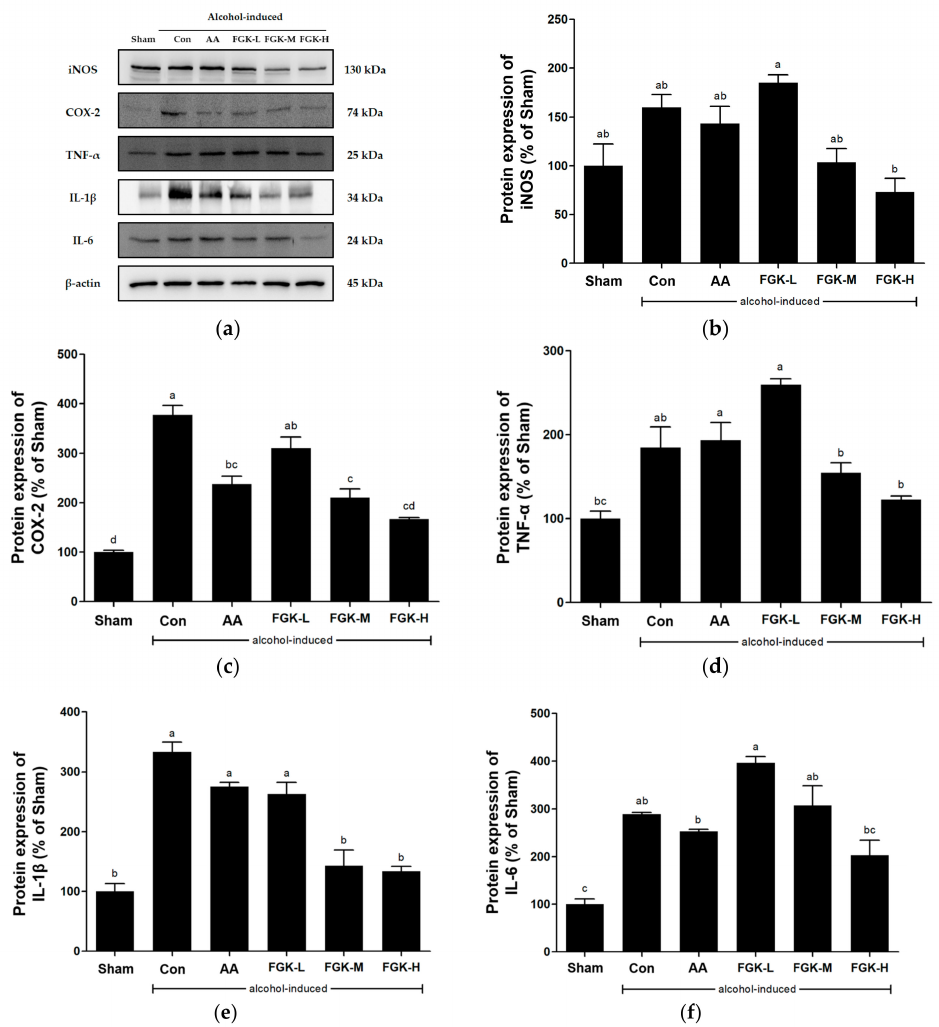
Figure 7. Effects of fermented gold kiwi (FGK) on liver inflammatory mediator levels in alcohol- induced mice. ( a ) Protein expression; ( b ) iNOS; ( c ) COX-2; ( d ) TNF- α ; ( e ) IL-1 β ; and ( f ) IL-6. Sham, mice treated with only saline; Con, mice treated with alcohol and saline; AA, mice treated with alcohol and ascorbic acid (25 mg/kg); FGK-L, -M, -H, mice treated with alcohol and FGK at 50, 126, and 250 mg/kg, respectively. Results expression as means ± SEM ( n = 8). a–d Different letters indicate significant differences ( p < 0.05) among the groups, as determined by Tukey’s